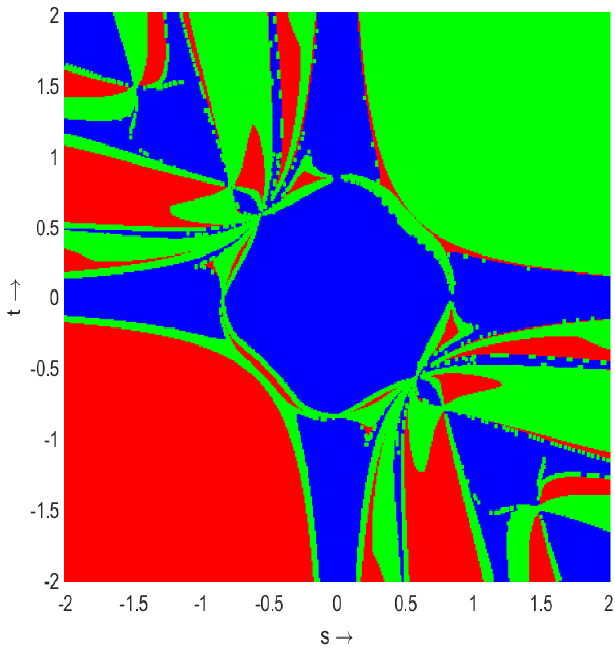
Figure 3. Dynamics of the method (4) associated with BA of Example 4. In Figure 4 (corresponding to Example 5), the red region is the set of all initial points from which the iterate (2) converges to ( − 1/2, − initial points from which the iterate (2) converges to ( − 1/2, is the set of all initial points from which the iterate (2) converges to ( 1, 0 ) . The black region represents the Julia